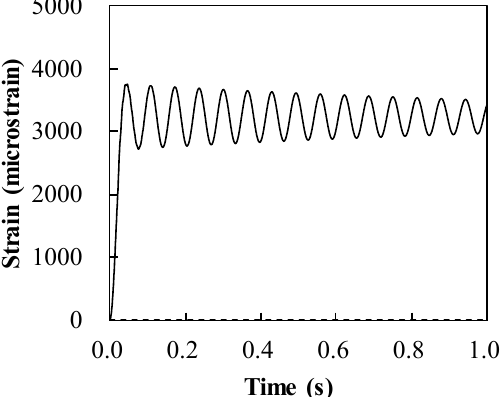
Figure 7. Strain development in steel of the hybrid system containing 8.4 mm thick steel slab and 8.0 mm thick ϕ 100 mm CFRP frame.